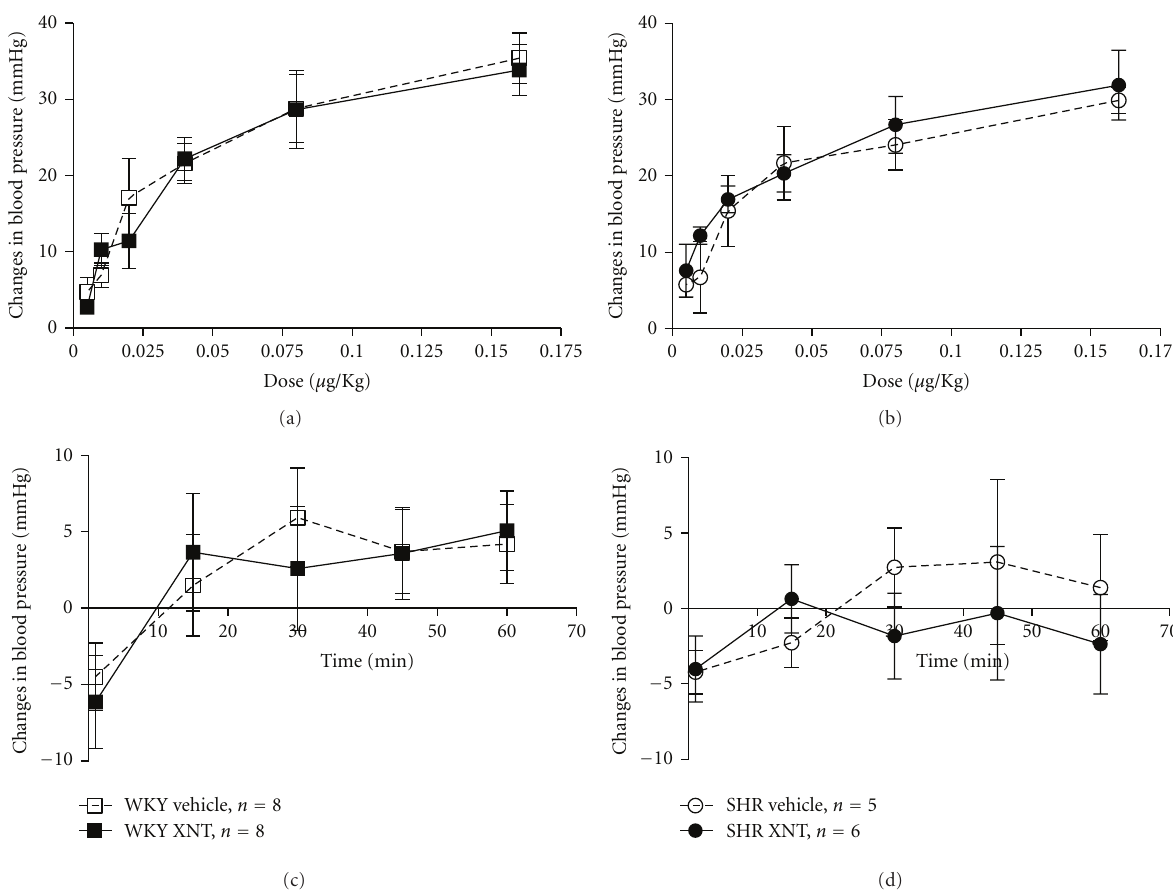
Figure 2: E ff ects of Ang II and Losartan on arterial blood pressure of rats chronically treated with XNT. The responses to increasing doses of Ang II were similar in vehicle- and XNT-treated (a) normotensive (Wistar-Kyoto rats—WKY) and (b) hypertensive (spontaneously hypertensive rats—SHR) rats. Likewise, the response to Losartan (0.25mg/kg) was similar in vehicle- and XNT-treated (c) normotensive (WKY) and (d) hypertensive (SHRs) rats. The blood pressure was measured through a catheter inserted into the carotid artery and Ang II and Losartan were administrated in bolus using the jugular